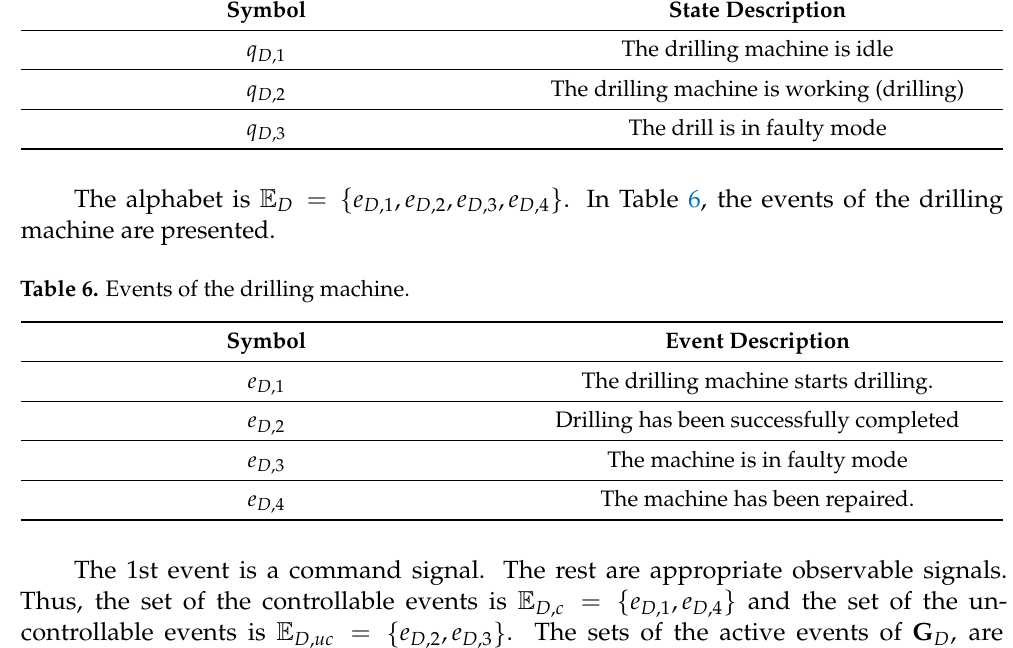
Table 5. States of the drilling machine. Symbol State Description q D ,1 The drilling machine is idle q D ,2 The drilling machine is working (drilling) q D ,3 The drill is in faulty mode